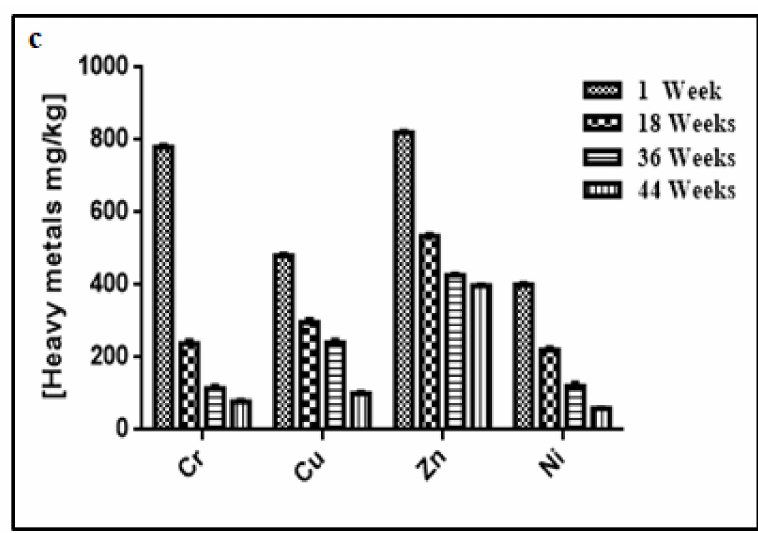
Figure 4. Contents of heavy metals (Cr, Cu, Zn, and Ni) during the co-composting process of mixes A ( a ), B ( b ), and C ( c ).